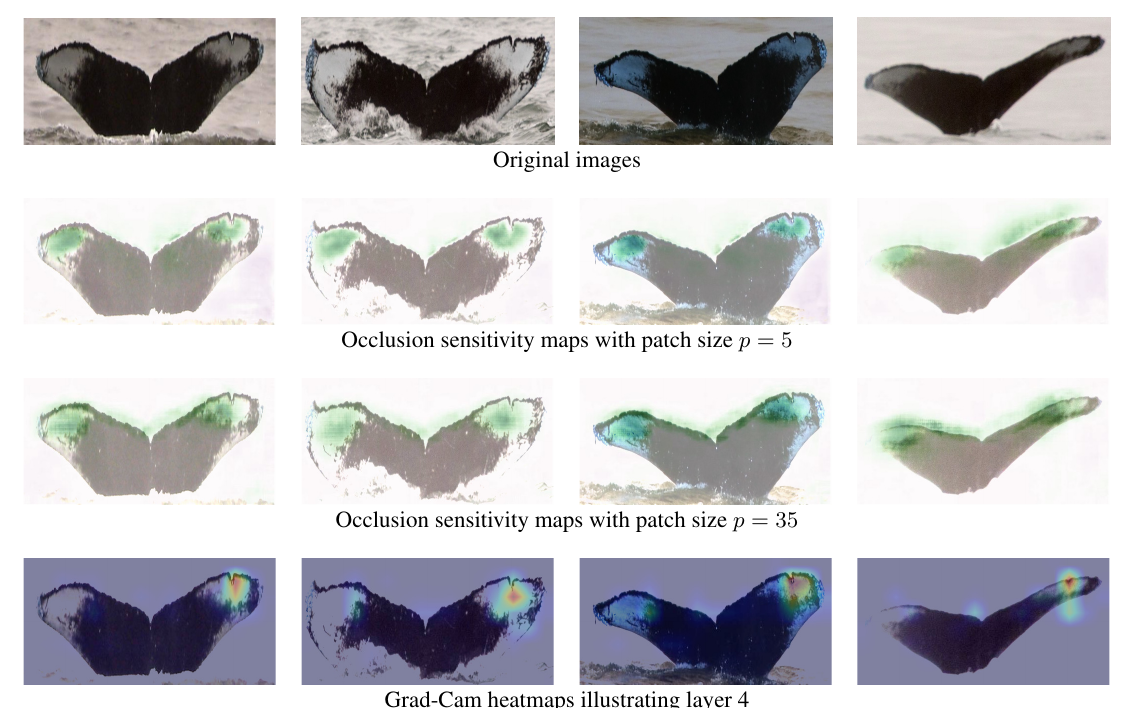
Figure 5. Visual comparison between OSM and Grad-CAM results using images representing class 261 . OSM is calculated for patch size p = 5 and p = 35 . Green colored areas represent pixels that have a positive influence on the class shown. Purple pixels are indications of other classes. The white colored areas have no influence on the classification according to OSM. The selected layer to be visualized in the approach of Grad-CAM is Layer 4 . For a better visualization, we overlayed the heatmap with the original